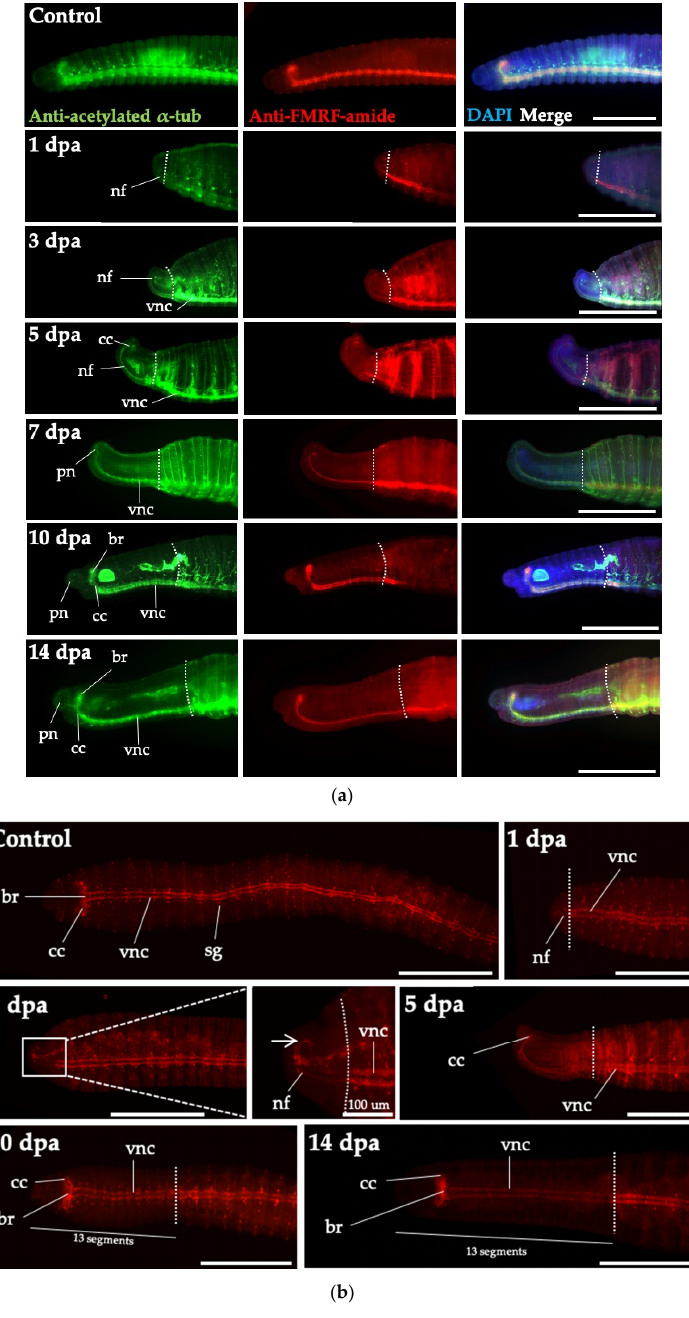
Figure 6. Visualization of nervous system regeneration. ( a ) The nervous system regeneration in the head region of P. excavatus was visualized using anti-acetylated α -tubulin staining (green) and anti-FMRF-amide staining (red) at indicated dpa. Nuclei are marked by DAPI staining (blue). Dotted lines represent the position of amputation. At 1 dpa, the wound at the amputated site is healed. The nervous system regenerates and nerve connections from the brain to the ventral nerve cord are clearly visualized. Regenerative tissues are shown in lateral view, with the dorsal side on the top. Scale bar, 500 µ m. ( b ) The process of nervous system regeneration in the head region of P. excavatus was visualized using anti FMRF-amide staining (red). At 3 dpa, the white arrow indicates the loop of circumesophageal connectives. Regenerative tissues are shown in ventral view. Abbreviations: br, brain; cc, circumesophageal connective; nf, nerve fibers; pn, palp nerves; sg, segmental ganglia; vnc, ventral nerve cord. Scale bar, 500 µ